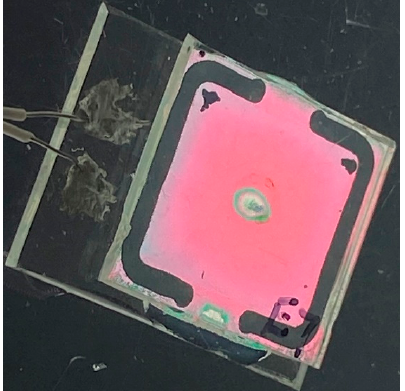
Figure 7. A photo of damaged E7 test cell taken between crossed polarizers on a white light table. The pink area shows homogeneous alignment, the middle circle is the laser exposure area, and the black spot is the damaged pattern. Both filling holes were sealed by epoxy sealants.